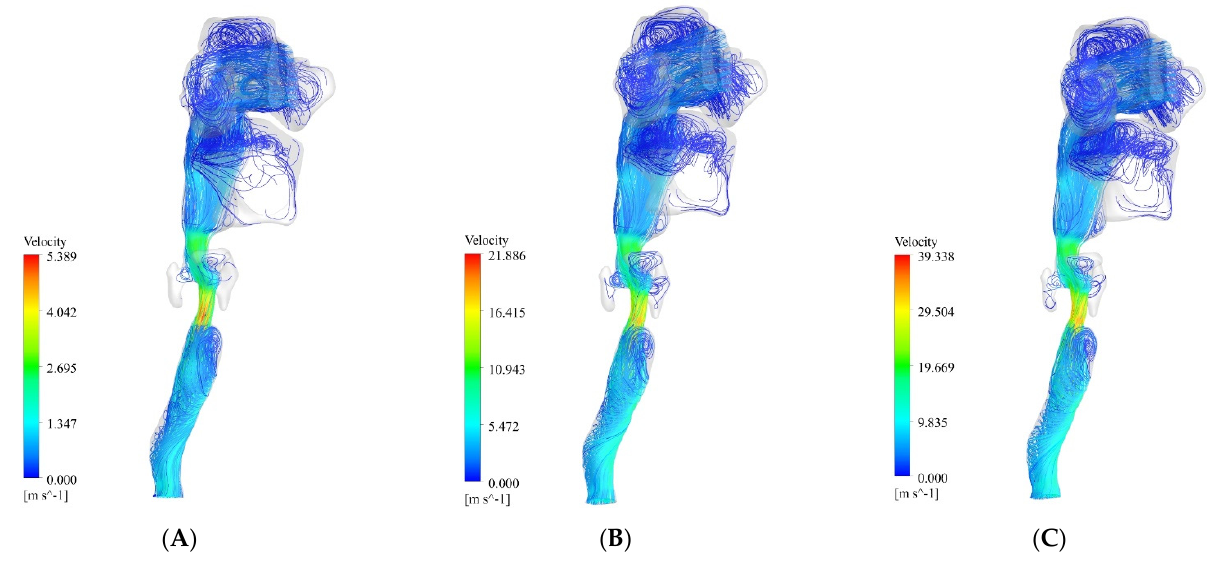
Figure 4. Streamlines of the airflow at three flow rates of 13 L/min, 55 L/min, and 100 L/min. ( I ) 13 L/min. ( B ) 55 L/min. ( BI ) 100 L/min.